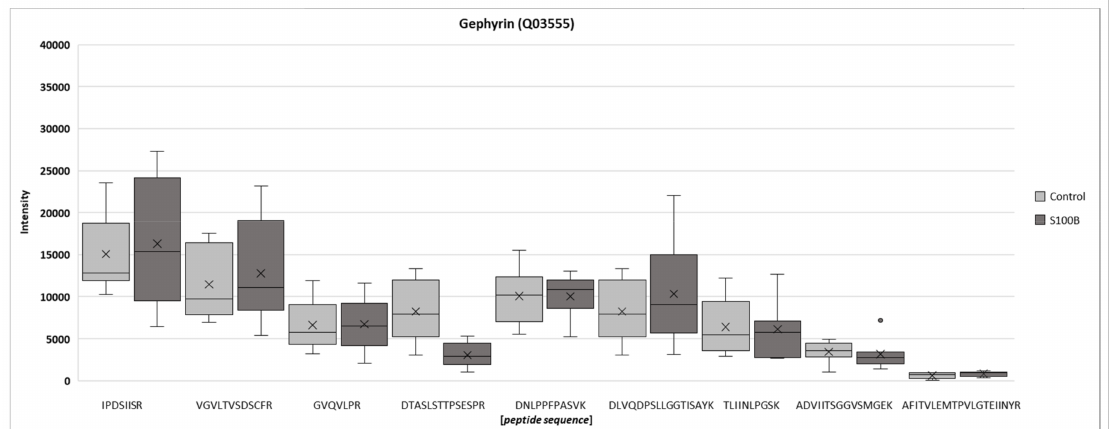
Figure 4. Mass spectrometry-based intensities of gephyrin 14 days after S100B injection. Nine unique peptides associated with gephyrin were differentially expressed in rat retinae 14 days after S100B immunization compared to control retinae (no